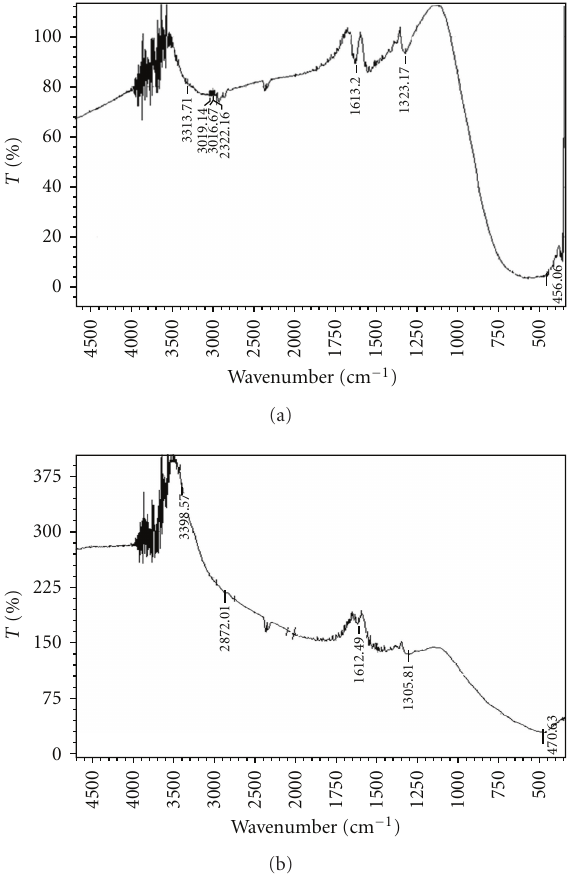
Figure 8: FT-IR spectra of (a) undoped TiO 2 and (b) 1.25wt.% Mg +2 -TiO 2